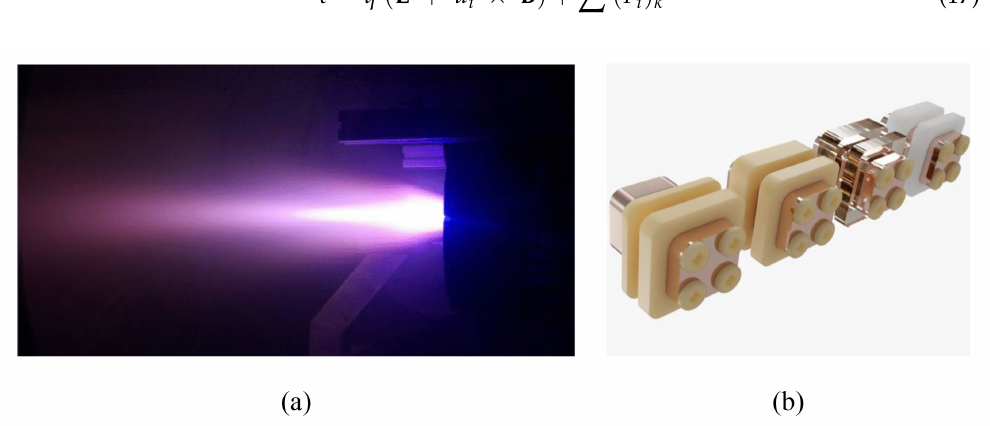
Figure 10. Electromagnetic thruster examples: ( a ) IRS AF-MPD thruster ZT1 in operation, size 40 mm in diameter [79] ( b ) AIS-gPPT3-1C Single-Channel Gridded Pulsed Plasma Thruster, size [40 × 38 × 24] mm credit: Applied Ion Systems.